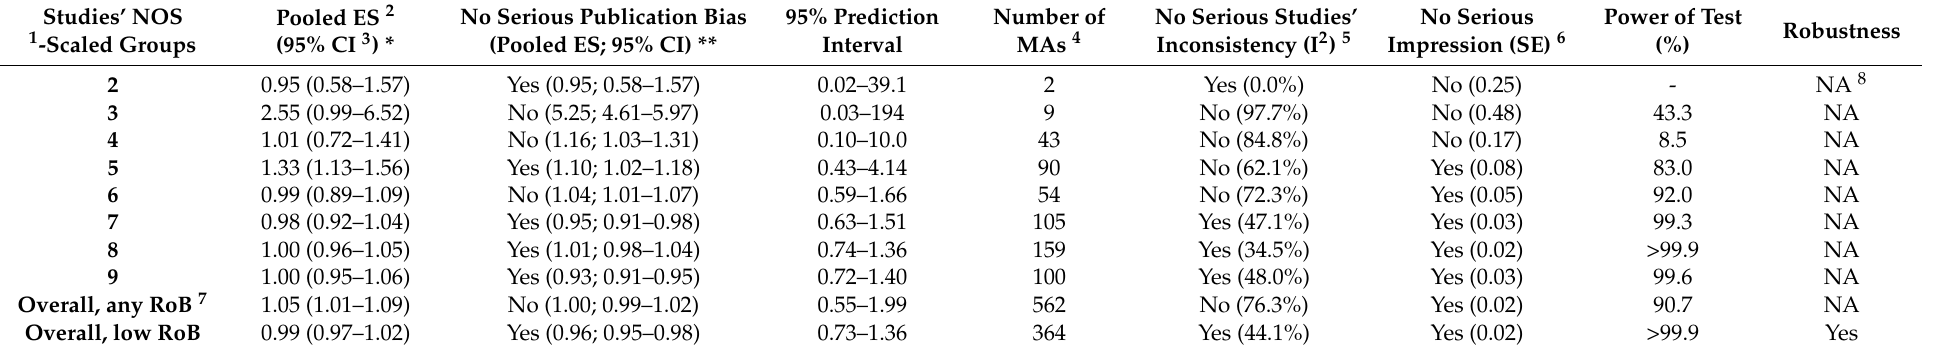
Table 1. Overall and NOS-grouped effect sizes, including parameters of the strength of evidence, robustness, and prediction